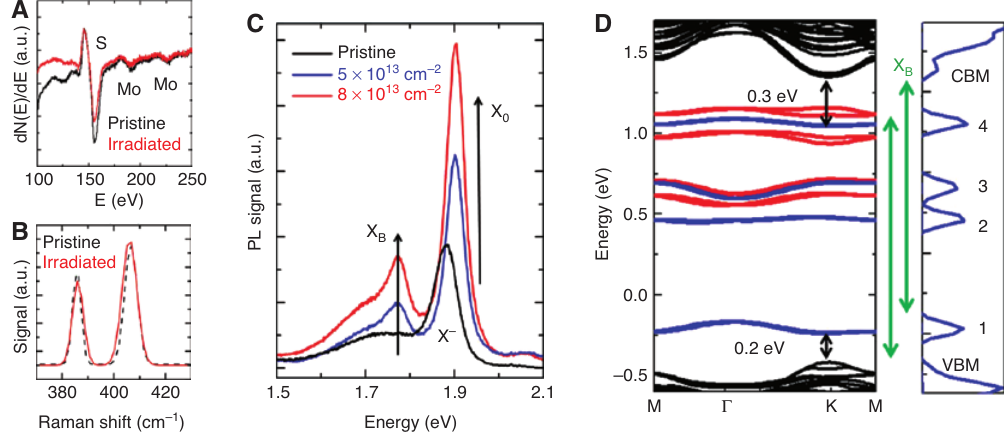
Figure 3: Defect-activated photoluminescence, taken from Ref. [50]. (A) Nano-Auger spectrum taken on MoS before and after irrediation with α particles at dose 8 × 10 13 cm −2 . (B) Raman spectrum of the same. 2 (C) PL spectrum for pristine and irradiated monolayers MoS at shown irradiation doses. The PL was taken at 77 K in N (50 Torr) environment 2 2 with a constant laser excitation power. The irradiation-caused enhancement in bound exciton (X ) and free exciton (X ) emission intensity B 0 are indicated. (D) Calculated band structure of monolayer MoS in the presence of di-S vacancies. Red levels with in the band gap are levels 2 appearing when S vacancies are introduced. Blue levels appear when N molecules interact with S vacancies. Right panel: Total density of 2 states of the monolayer MoS with S vacancies in the poresence of N . Here the modeled vacancy density is 7 × 10 13 cm −2 2 2